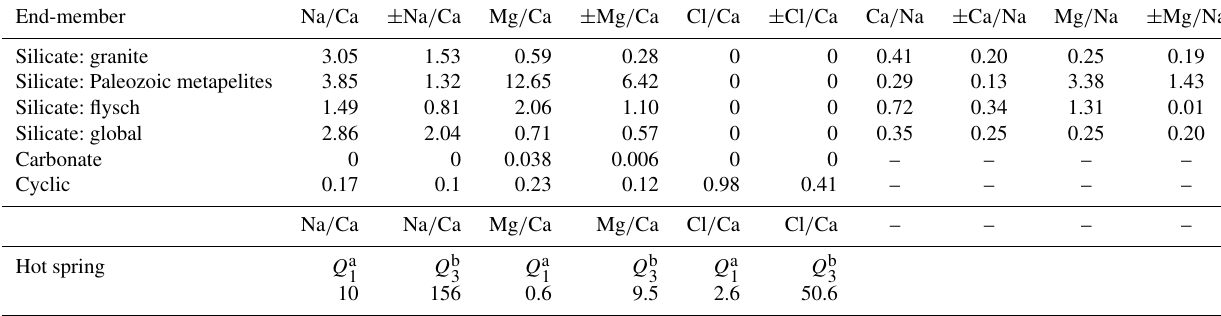
Table 1. Input end-members for the mixing